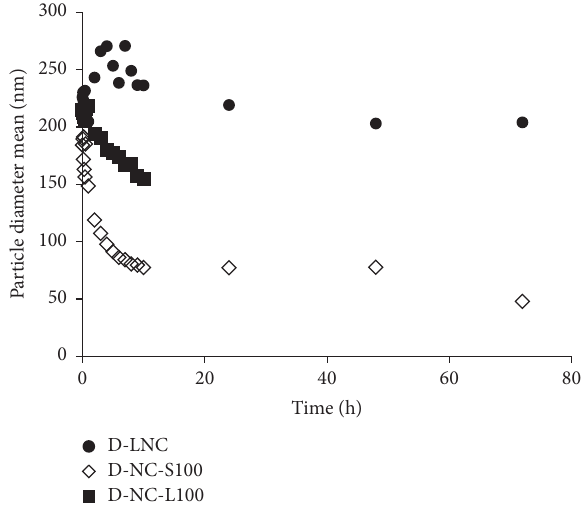
Figure 4: Particle size distribution over the time of drug release profile from dialysis sac method.